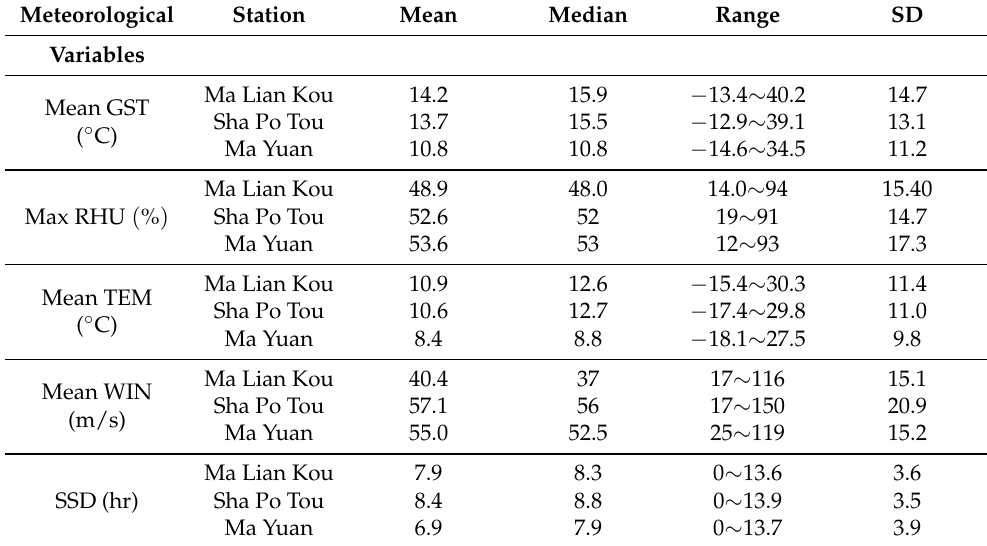
Table 3. Basic descriptive statistics of the measured meteorological variables at the three